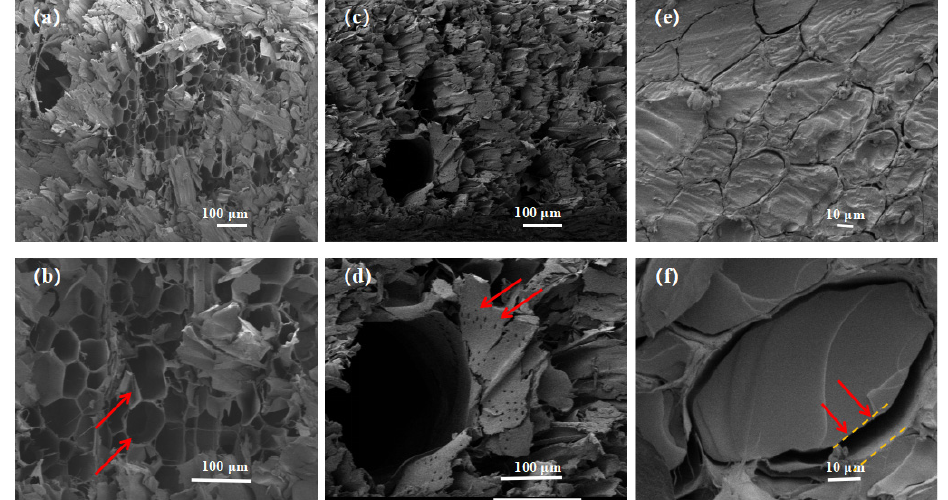
Figure 2. SEM images at different magnifications: ( a , b ) pristine wood sample, ( c , d ) lignin-modified decolorized wood sample, ( e , f ) optically transparent wood sample. The microscopic shape of the sample can be clearly seen at the red arrow in the fi gure.